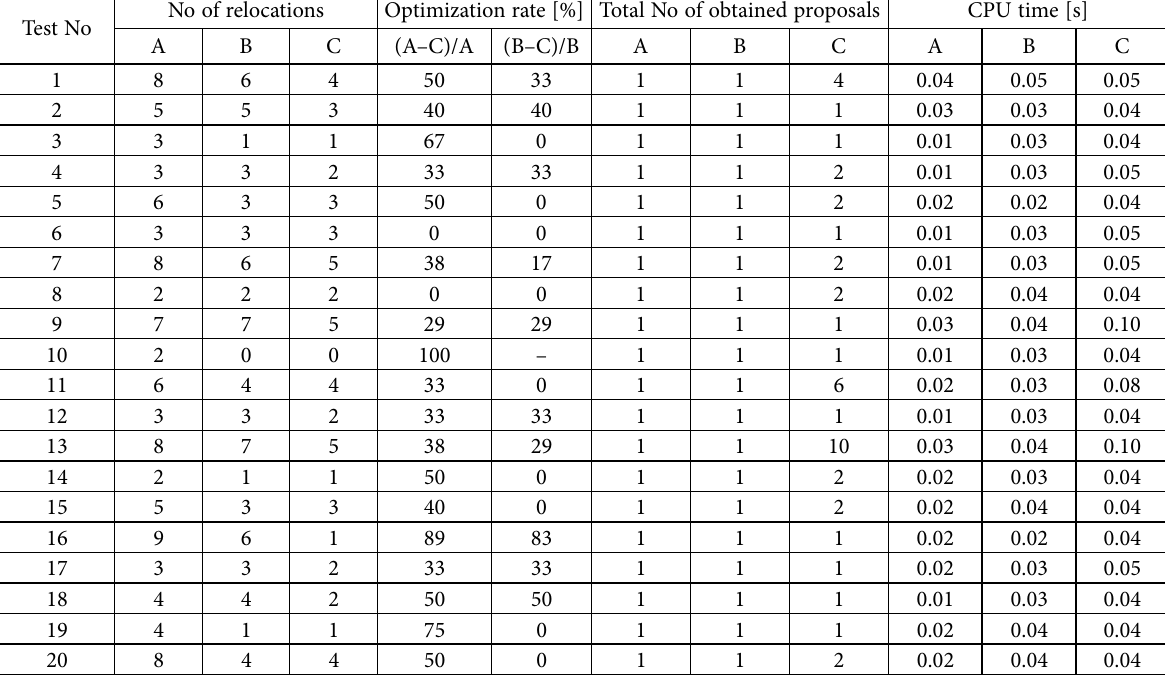
Table 4. Comparisons of performances for RTGC